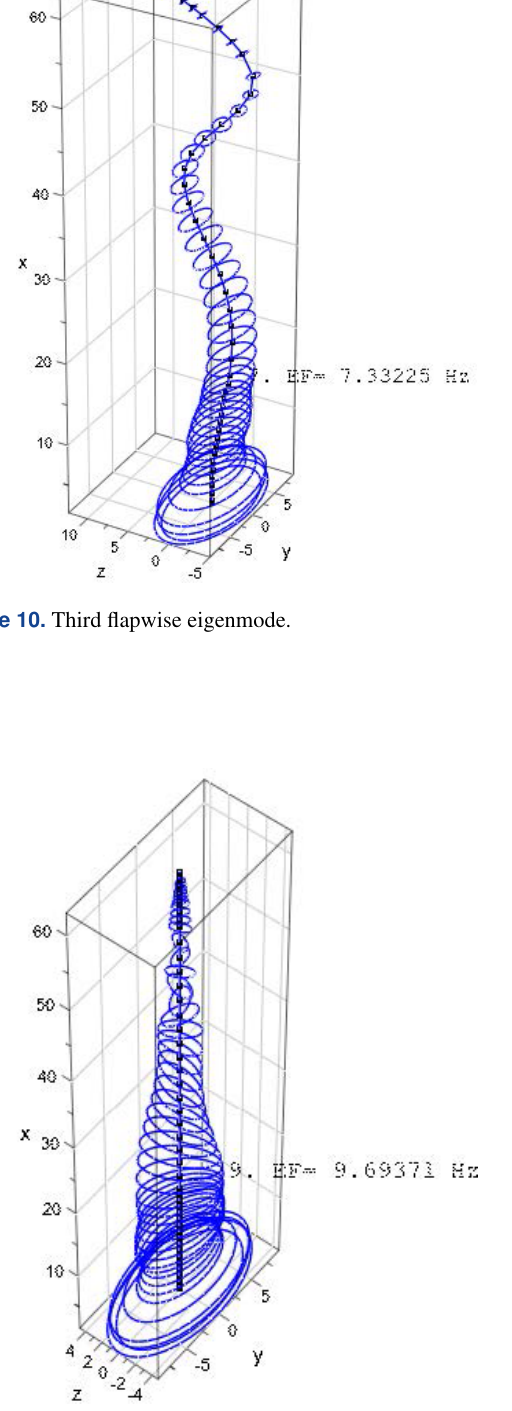
Figure 11. Second torsional